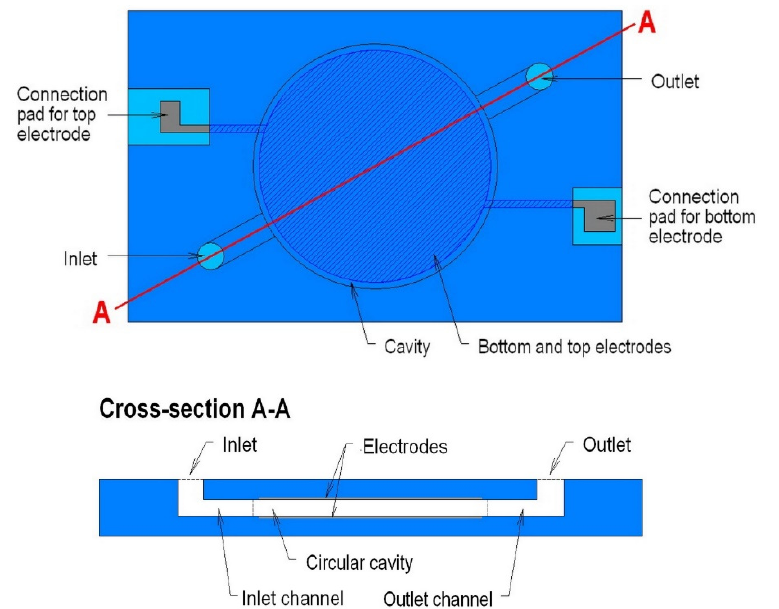
Figure 1. The layout (top view and cross-section) of a 3D LTCC-based ceramic structure for dielectric heating of liquids.